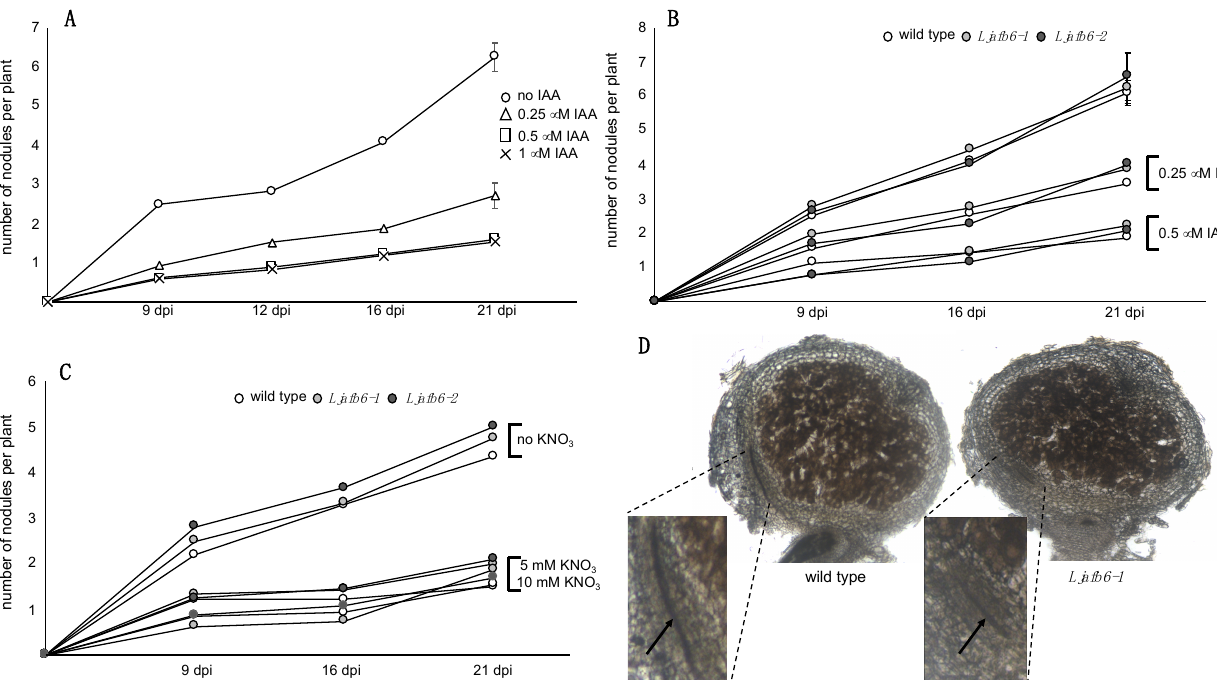
Figure 10. Symbiotic phenotypes of wild type and Ljafb6 plants. ( A ) Kinetic of nodulation in wild type plants grown in the presence of different concentrations of IAA. IAA concentrations are indicated. ( B ) Kinetic of nodulation in wild type and Ljafb6 plants grown in the presence of 0.25 and 0.5 μM IAA. ( C ) Kinetic of nodulation in wild type and Ljafb6 plants grown in permissive conditions (without nitrate) and inhibitory conditions (5 and 10 mM KNO 3 ). Nodules were scored weekly after inoculation, up to three weeks. KNO 3 concentrations are indicated. ( D ) 80 μm vibratome sections of wild type and Ljafb6-1 nodules. Higher magnification images refer to zones of the nodular sections where vascular bundle structures are visible (arrows).